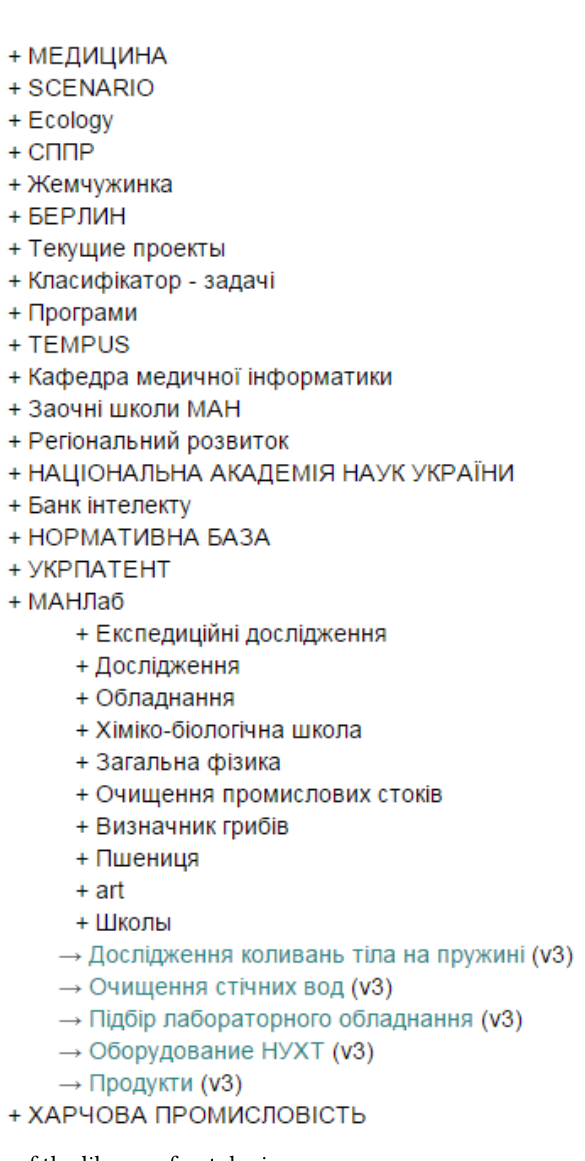
Figure 3: General view of the library of